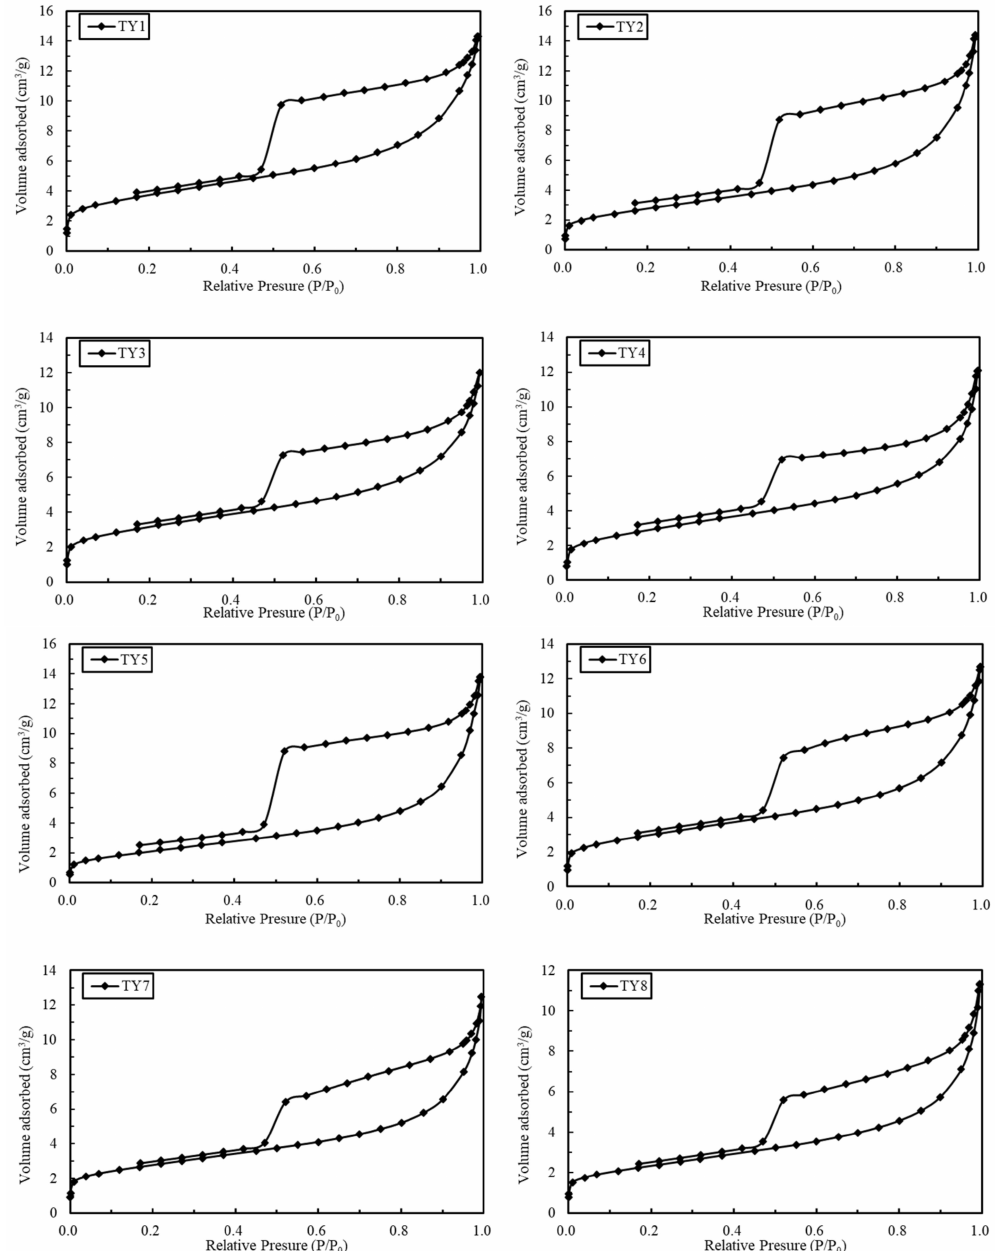
Figure 2. Low-pressure N 2 adsorption–desorption isotherms of the shale samples from Taiyuan